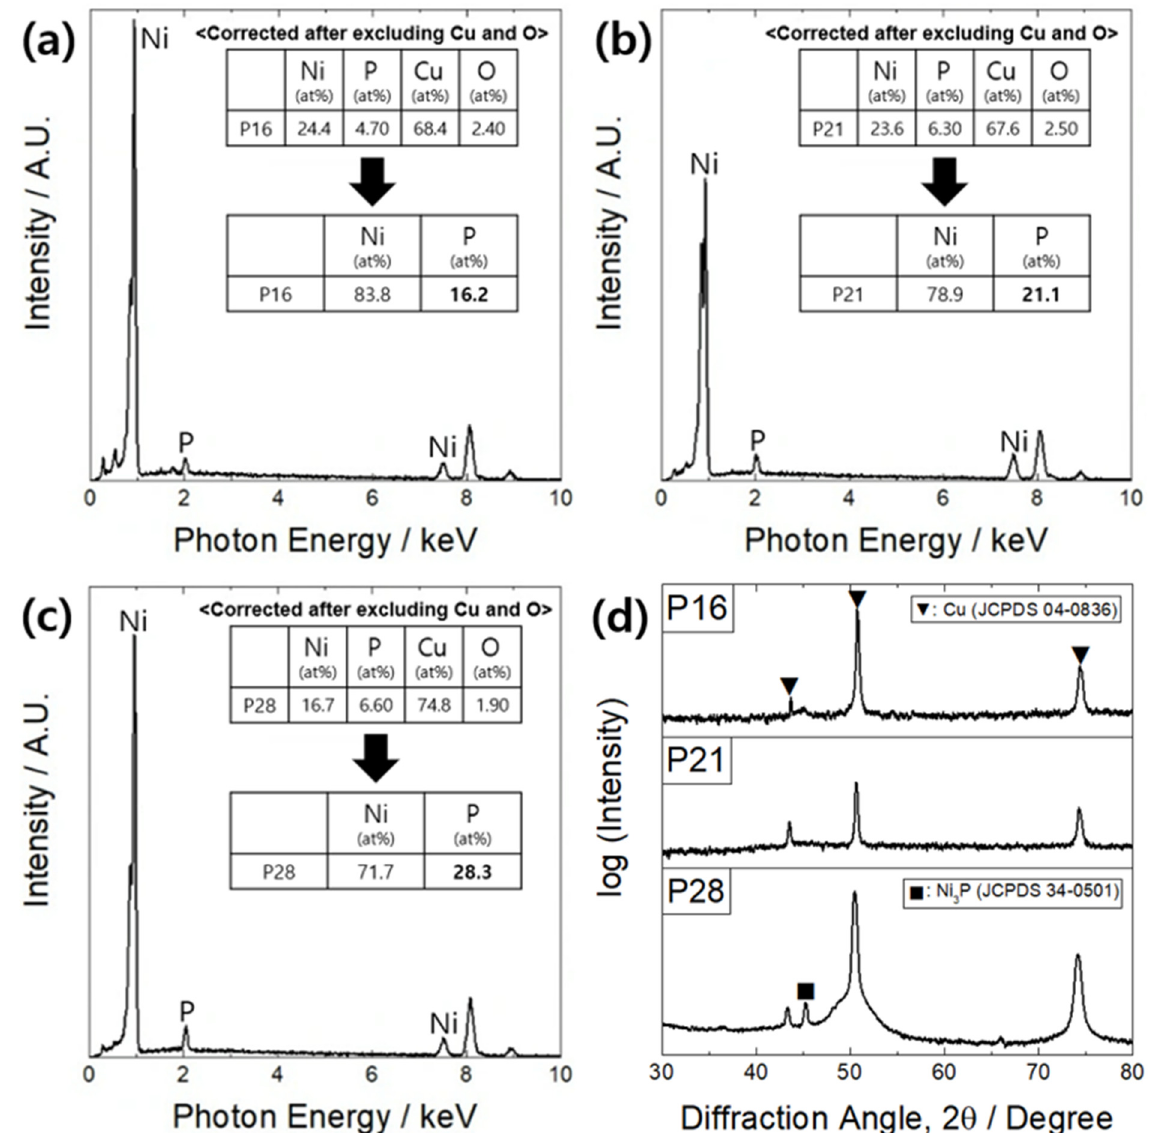
Figure 2. EDS spectra together with chemical composition ratios of the nickel phosphide thin films: ( a ) sample P16, ( b ) sample P21, and ( c ) sample P28. ( d ) represents their XRD patterns.